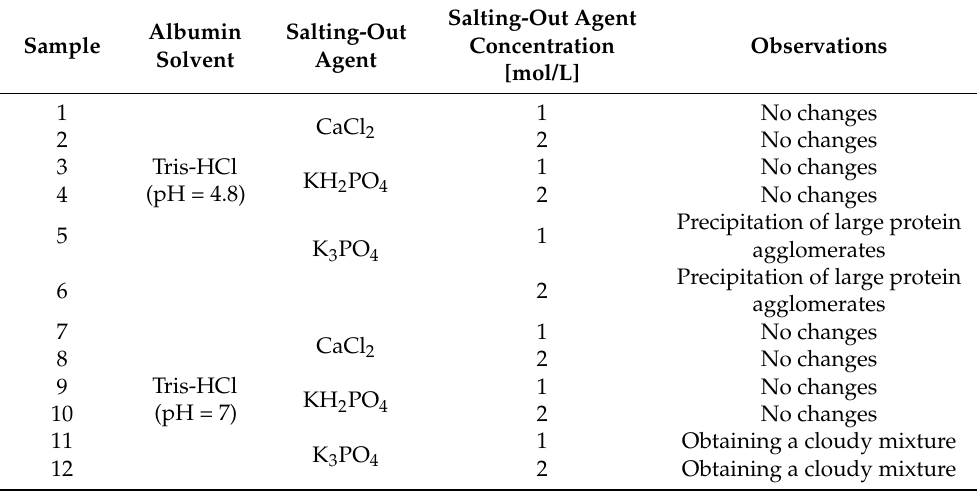
Table 1. The syntheses conditions of albumin-based carriers at a constant albumin concentration (2.0 g/L).